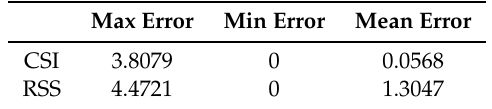
Table 2. The maximum, minimum, and mean of distance error value of the CSI and RSS.